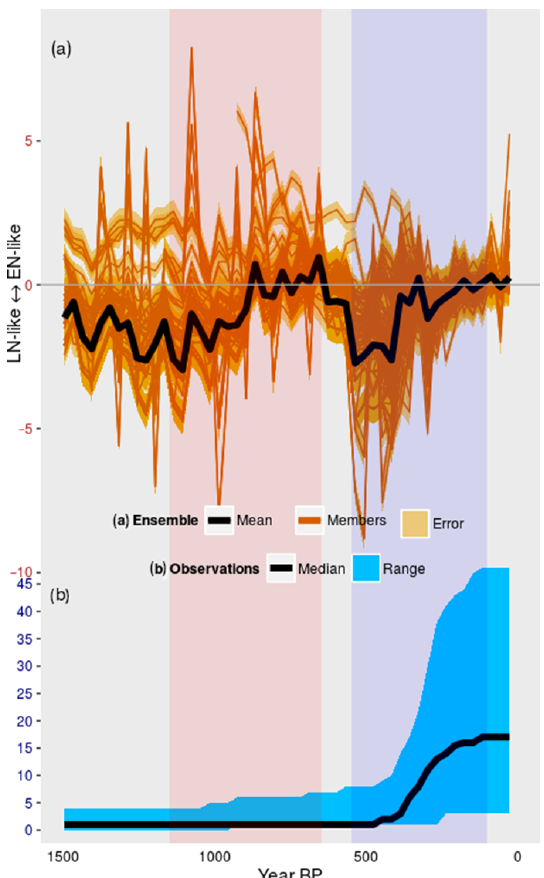
Figure 3. Temperature ENSO ensembles. As Fig. 2, but for tem- perature.